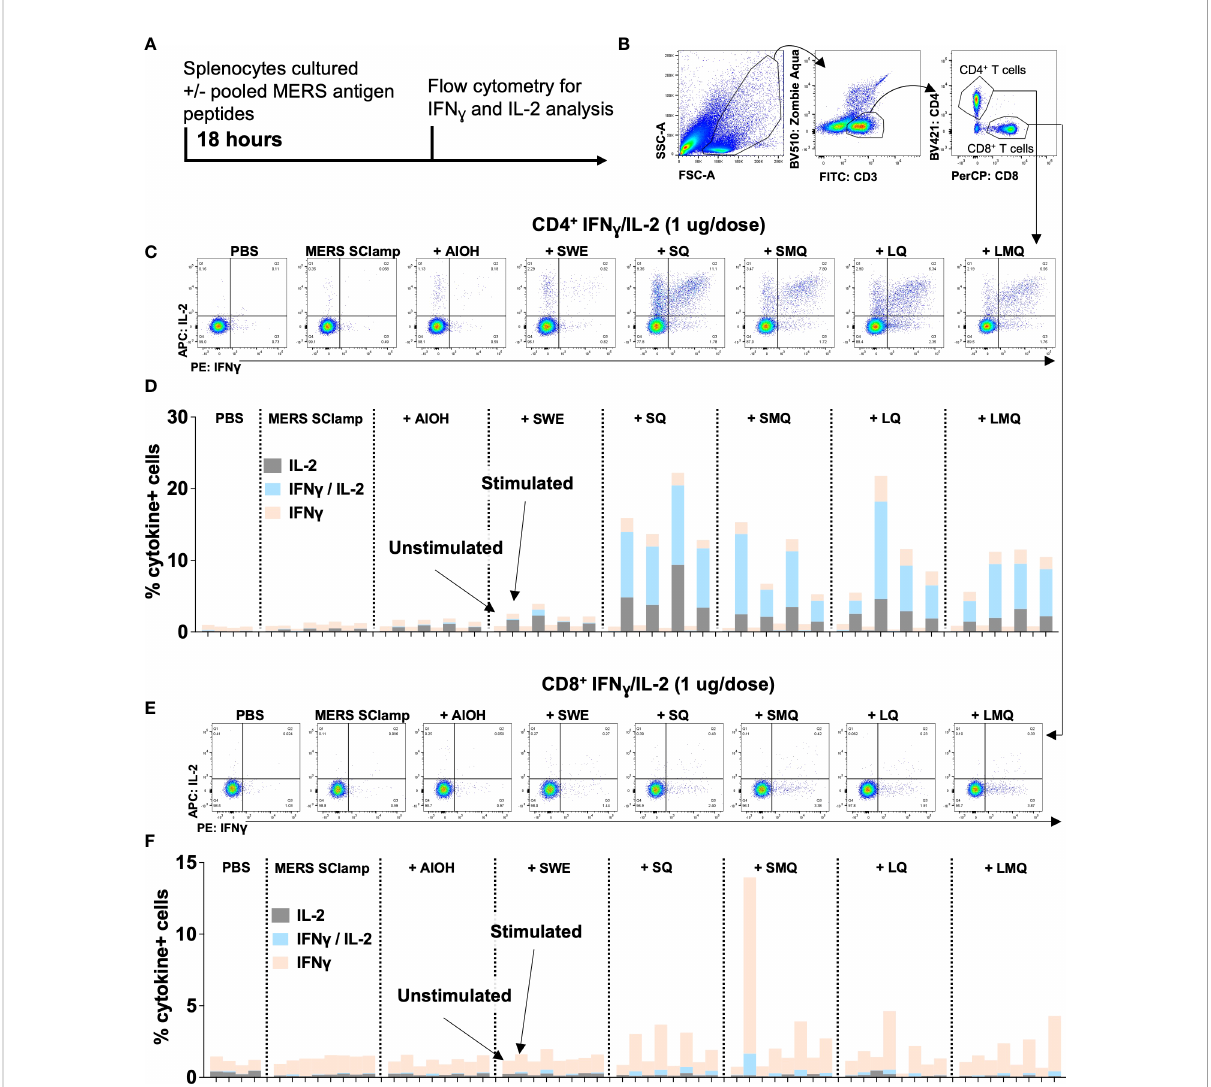
FIGURE 4 CD4 + and CD8 + T cell function differs following MERS SClamp immunization depending on adjuvant used. (A) Splenocytes were isolated from C57/BL6 mice immunized according to Figure 1A, incubated with or without pooled MERS SClamp antigen peptides for 4 hours in the presence of protein transport inhibitors followed by fl ow cytometry analysis. (B) Gating on live cells of lymphocyte morphology, T cells (CD3 + CD8 + or CD3 + CD4 + ) were assessed for expression of interferon gamma (IFN Ɣ ) and interleukin-2 (IL-2). (C) Representative fl ow cytometry plots of IFN Ɣ and IL-2 by CD4 + T cells treated as described in (A) , and (D) Data summary. (E) Representative fl ow cytometry plots of IFN Ɣ and IL-2 by CD4 + T cells treated as described in (A) , and (F) Data summary. Individual data points for each mouse have been presented, n = 2 – 4/group. Related to Figure